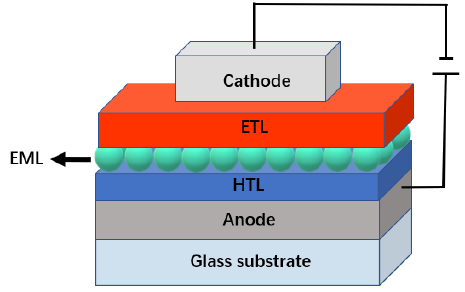
Micromachines 2022 , 13 , x Figure 11. Schematic diagram of QLED structure. Figure 11. Schematic diagram of QLED structure.